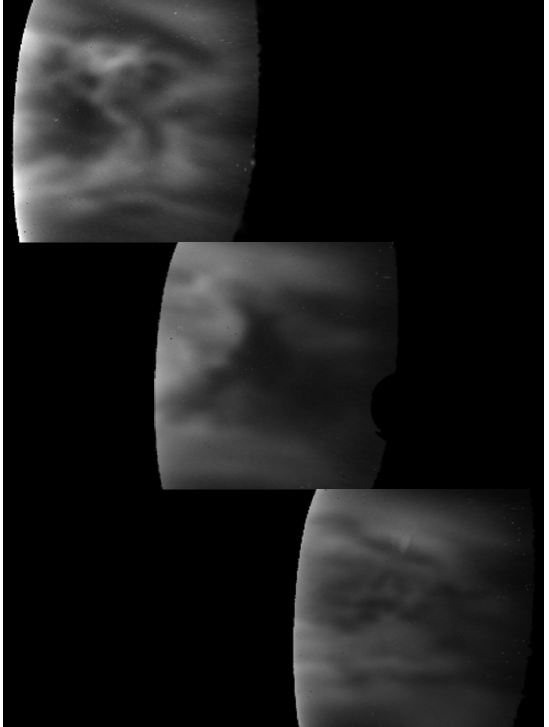
Figure 1. Venus’ lower cloud deck as seen from the Earth’s point of view with the Telescopio Nazionale Galileo (TNG). These images were obtained in the near-infrared Earth transparency window at 2.28 µ m with the camera NICS after daylight correction. Given the diversity of cloud’s morphological features and their high variability, we note that these images were obtained over three consecutive